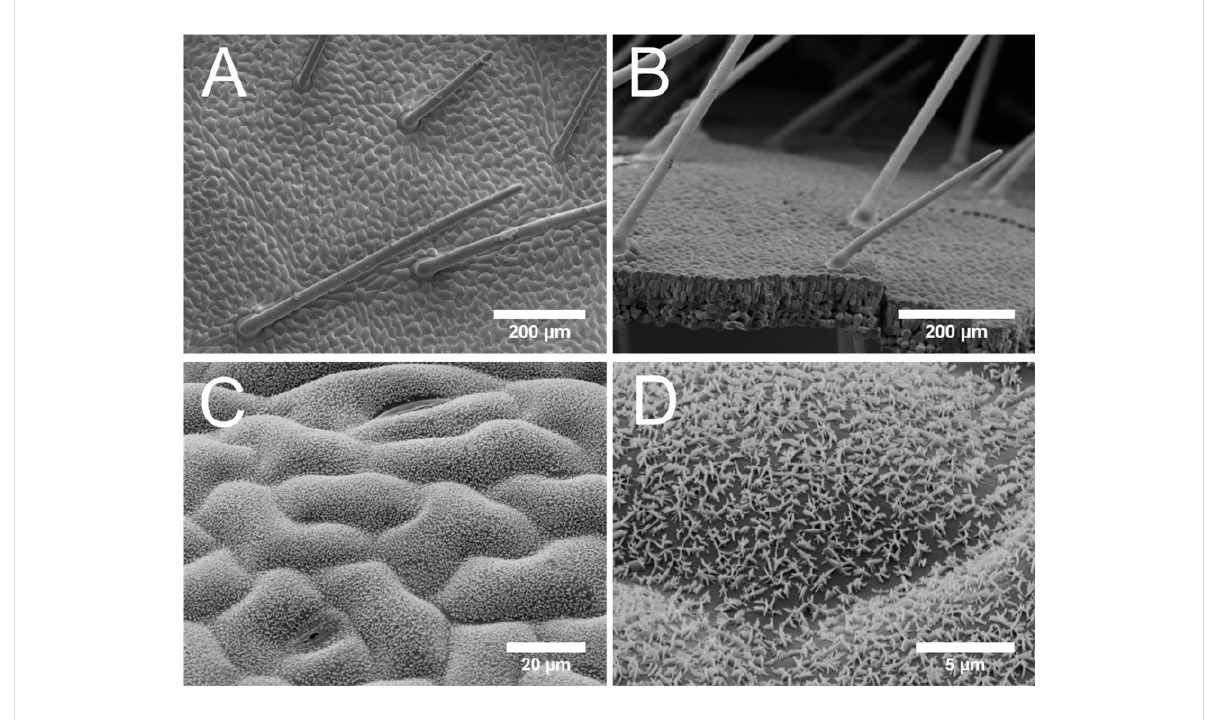
Figure 1: SEM micrographs of the untreated surface of a cryo-fixed sample of Glycine max L. leaves (upper leaf side) (A, B) and substituted with glycerol (C, D). In (A) a top view of the cryo-fixed adaxial surface is shown and the distribution of hairs and the undulated cell boundaries are illus- trated. Figure 1B shows a side view of the leaf, showing a broken edge with hairs on the upper leaf side. In Figure 1C a detailed view of the slightly convex shape of the epidermal cells is shown. Figure 1D is a larger magnification image of Figure 1C, which shows the epicuticular wax platelets arranged in rosettes.